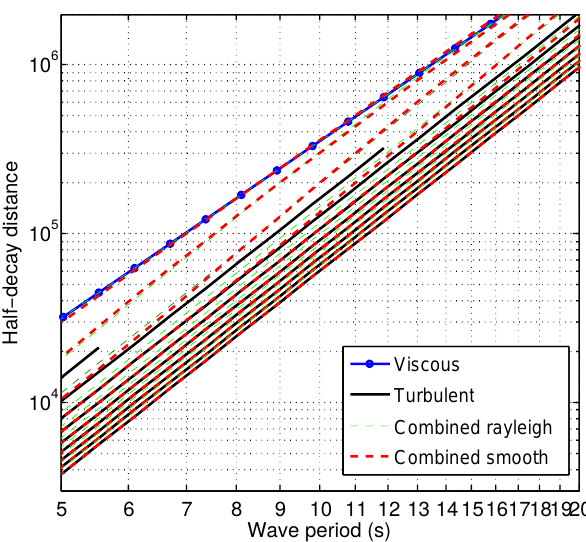
Figure B1. Half-decay distances as a function of the wave period T and the significant wave height H s . H s is varied from 0.5 (upper curves) to 5m (lower curves). The combination of viscous and tur- bulent expressions is made using either a Rayleigh distribution of wave height and computing the dissipation for each wave height in the distribution or by a smooth linear combination of the viscous and turbulent terms adjusted to reproduce the Rayleigh